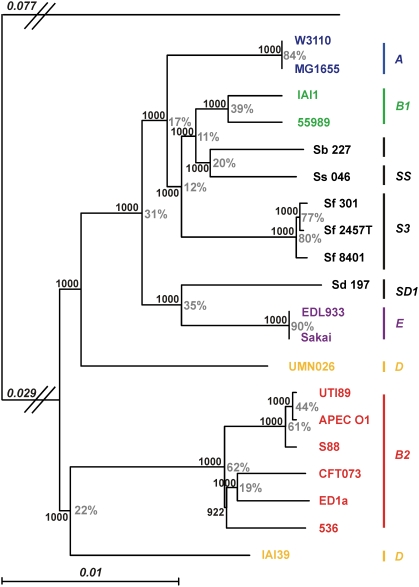
Maximum likelihood phylogenetic tree of the 20 Escherichia coli and Shigella strains as reconstructed from the sequences of the 1878 genes of the Escherichia core genome.The earliest diverging species, E. fergusonii, was chosen to root the tree. The numbers at the nodes correspond, in black, to the bootstrap values (1000 bootstraps) and, in grey, to a “consensus strength”, which is the number of genes that confirms the bipartition (see Materials and Methods). The latter value is displayed only in instances where consensus and tested trees correspond. The branch length separating E. fergusonii from the E. coli strains is not to scale; the numbers above the branch indicate its length. Phylogenetic group membership of the strains is indicated with bars at the right of the figure.